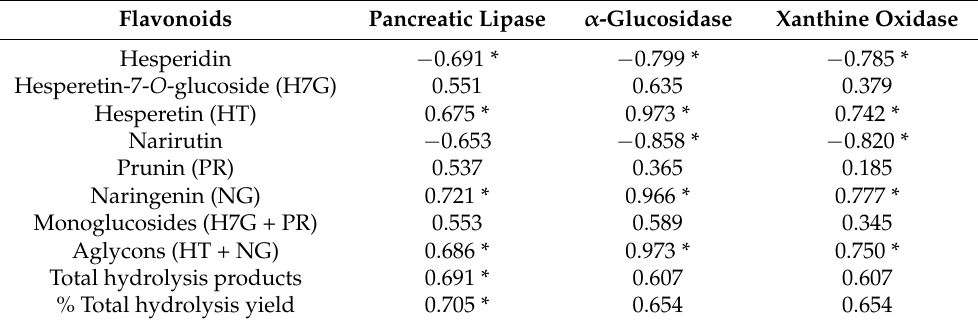
Table 5. Pearson correlation coefficients between flavonoid yields and enzyme inhibitory activities in subcritical water hydrolysates from immature Citrus unshiu